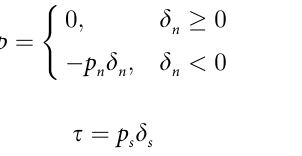
PLOS ONE | https://doi.org/10.1371/journal.pone.0266241 April 7,